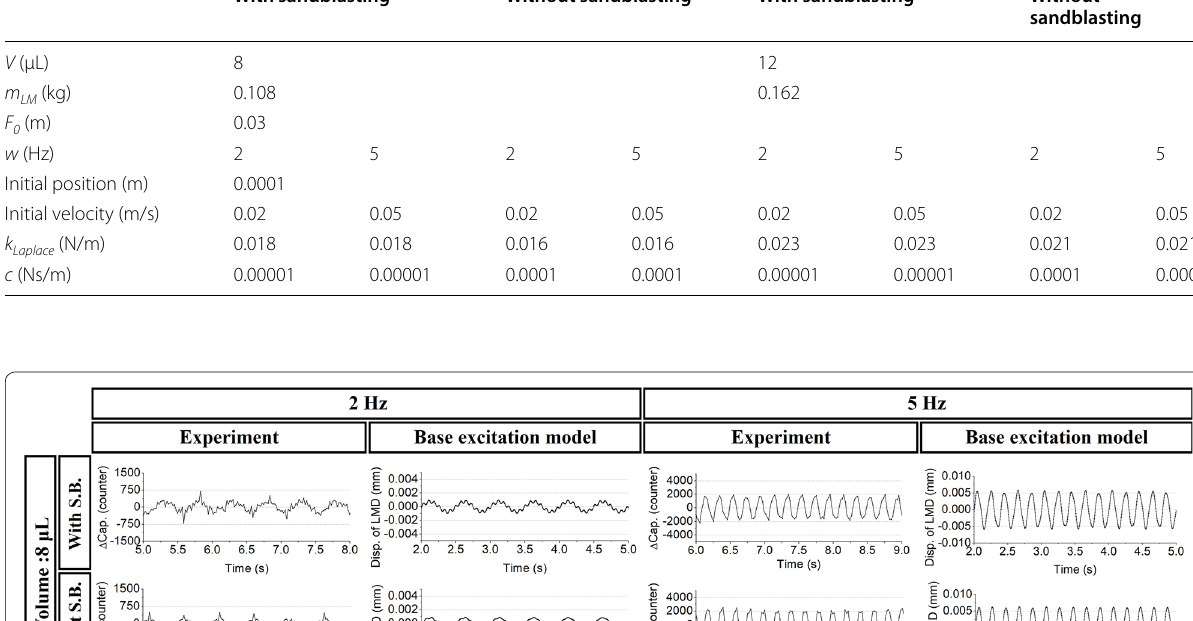
Table 1 Parameters of the base excitation model determined according to the experimental conditions With sandblasting Without sandblasting With sandblasting